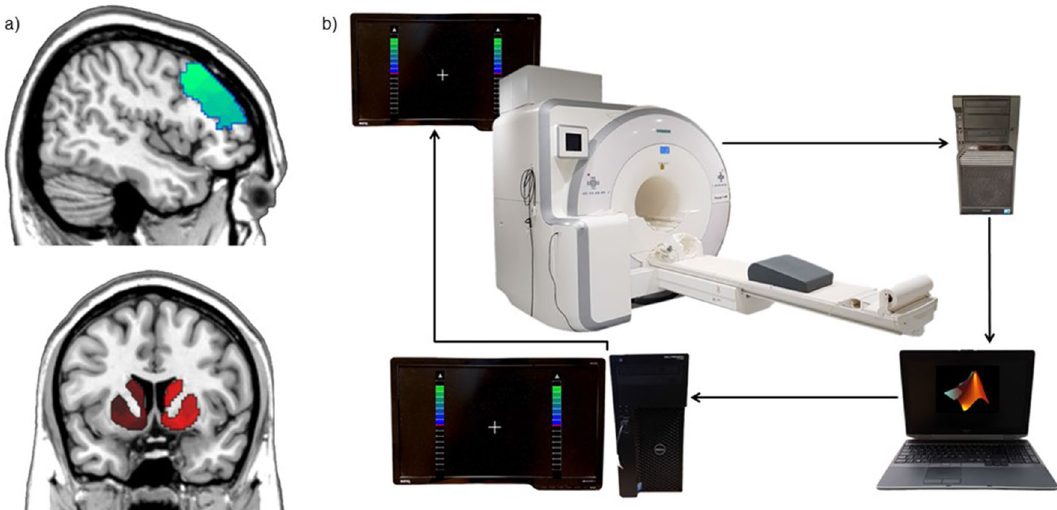
Figure 1. Experimental setup. ( a ) DLPFC-striatum target network. Bilateral ROIs in the DLPFC and the striatum were predefined and projected into the individual anatomy of the participant to extract the online feedback signal during NF training. ( b ) rt-fMRI NF setup. Images are sent to a laptop running in-house MATLAB scripts for pre-processing and extraction of the neurofeedback signal. The feedback signal represents the averaged functional connectivity between the ROIs in the DLPFC and the striatum. The feedback value is forwarded to a computer running Presentation software and is displayed in the scanner as a thermometer value that is continuously updated every